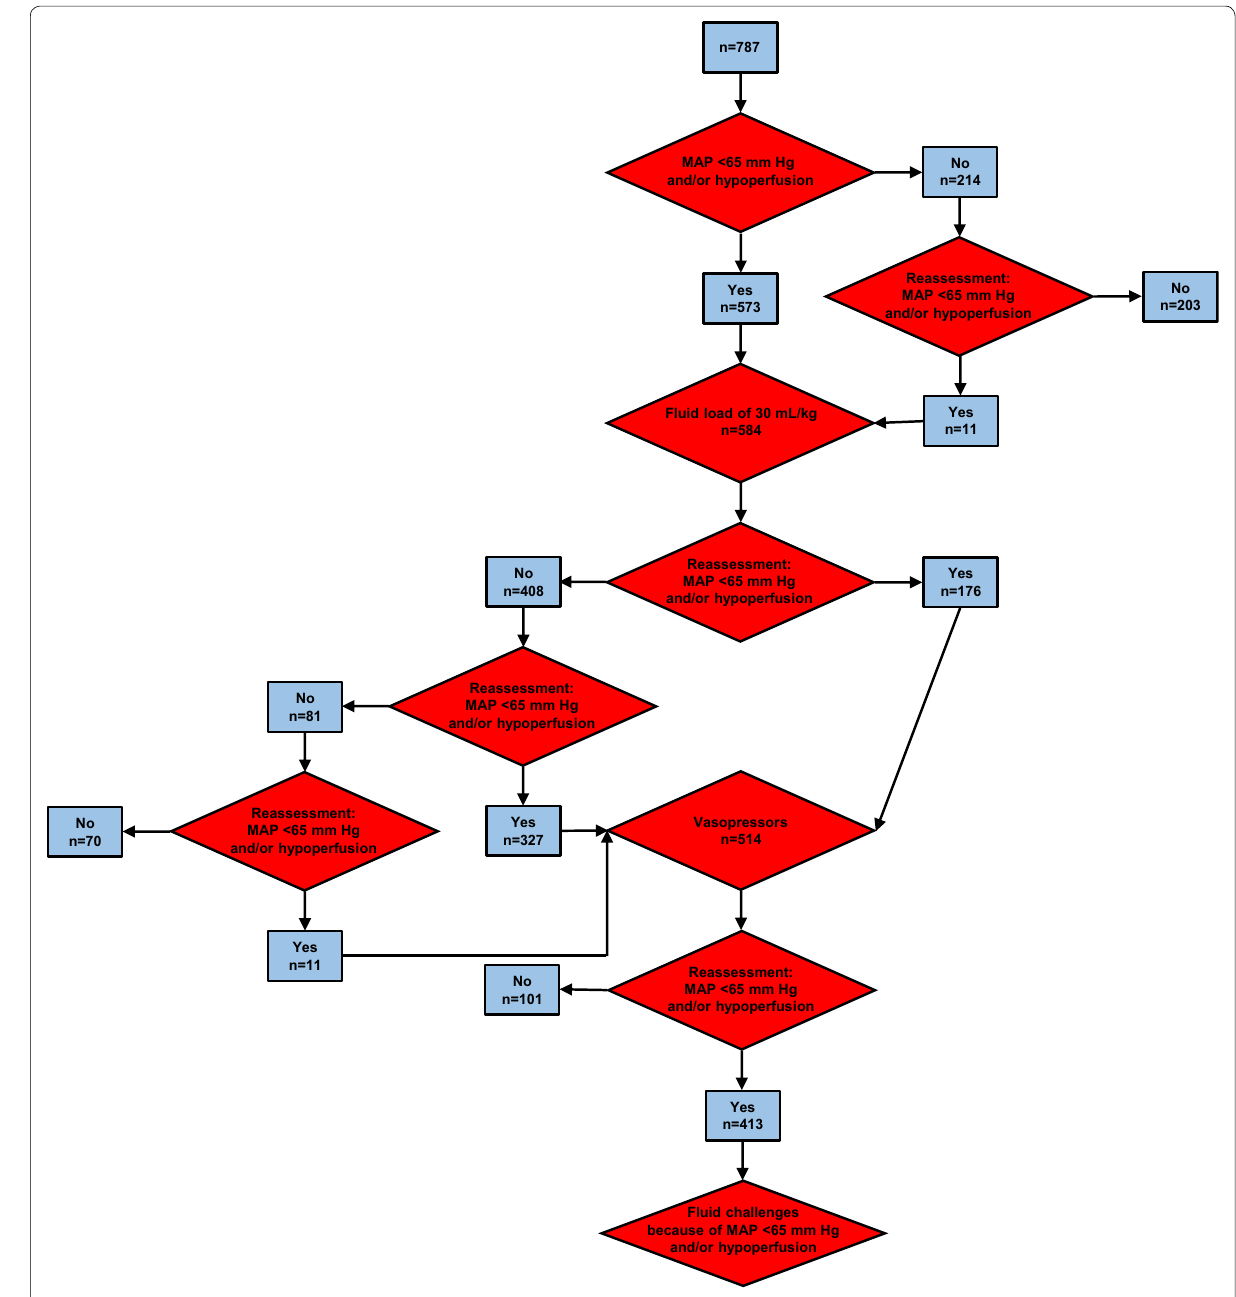
Hypoperfusion was initially defined as blood lactate levels >2.0 mmol/L, oliguria, capillary refill time (CRT) >3 sec, and presence of mottling. After the initial fluid load of 30 mL/kg, we also considered the presence of heart rate >120 beats/min, central venous pressure <6 mm Hg, lactate clearance <20% for 2-h, central venous oxygen saturation <70%, central venous- arterial PCO 2 >6 mm Hg, and urine output <0.5 mL/kg/h. Fig. 1 Flowchart of the